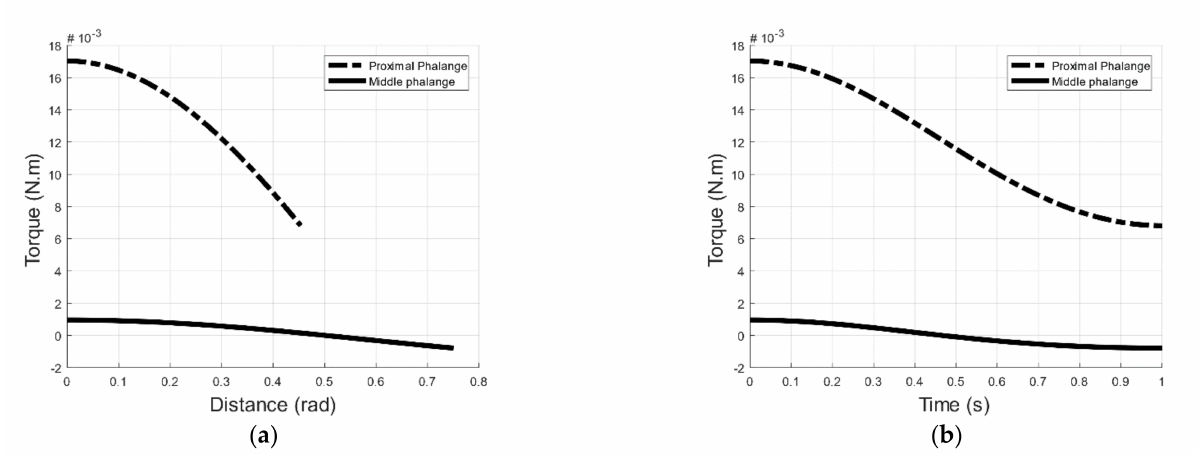
Figure 8. Torque obtained from Newton–Euler formulation for the movement of the proximal and middle phalanxes of the proposed exoskeleton; ( a ) describes the torque vs. displacement, and ( b ) describes the torque vs.